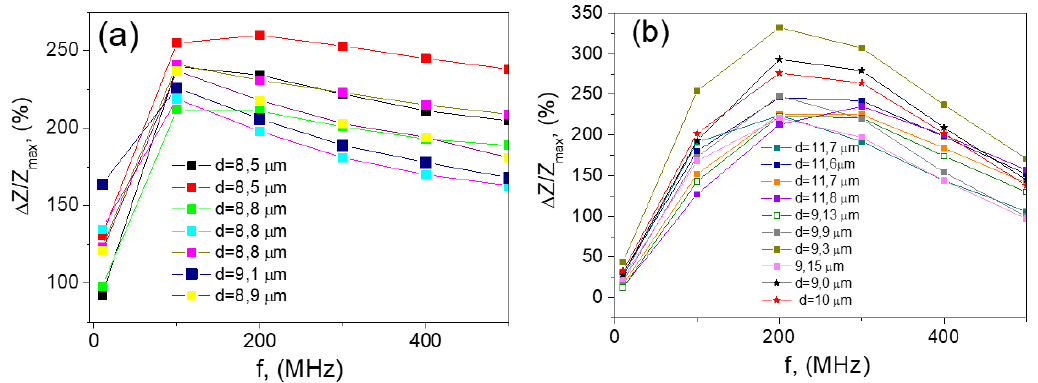
Figure 12. Frequency dependence of microwires № 5 with different metallic nucleus diameters. ( a ) metallic nucleus diameters ranging between 8.5 and 9.1 µ m; ( b ) metallic nucleus diameters between 9 and 11.7 µ m. Reprinted with permission from